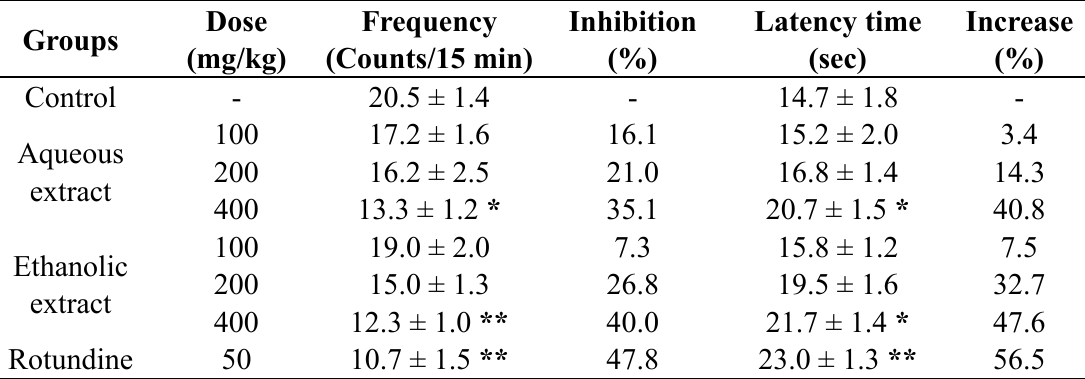
Table 2. Anti-nociceptive effects of the two extracts on acetic acid-induced writhing and hot plate test in